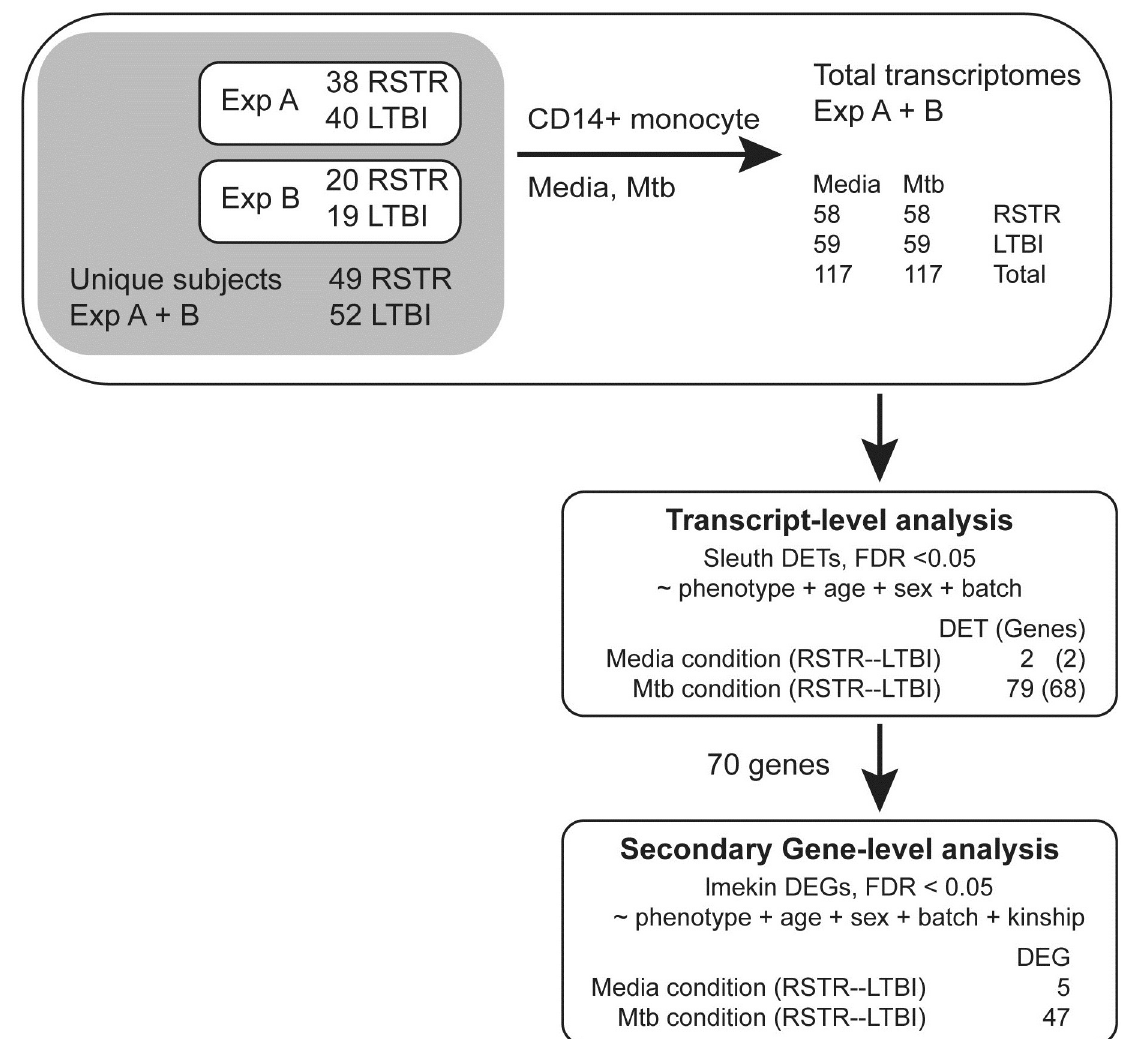
Fig 1. Experimental outline of donor monocyte infections, isoform-specific and gene-level differential expression analysis for the RSTR—LTBI contrast. Two independent experiments (Experiment A and B) were performed with CD14+ monocytes from the indicated subjects with partial overlap totaling 58 and 59 transcriptomes from 49 and 52 unique RSTR and LTBI subjects, respectively, in each condition (media or Mtb-stimulated). Primary transcript isoform differential expression analysis was performed using Sleuth, and among 68 genes with at least one differentially expressed transcript (DET, false discovery rate [FDR] < 0.05), a secondary gene-level analysis using lmekin that adjusts for genetic kinship was